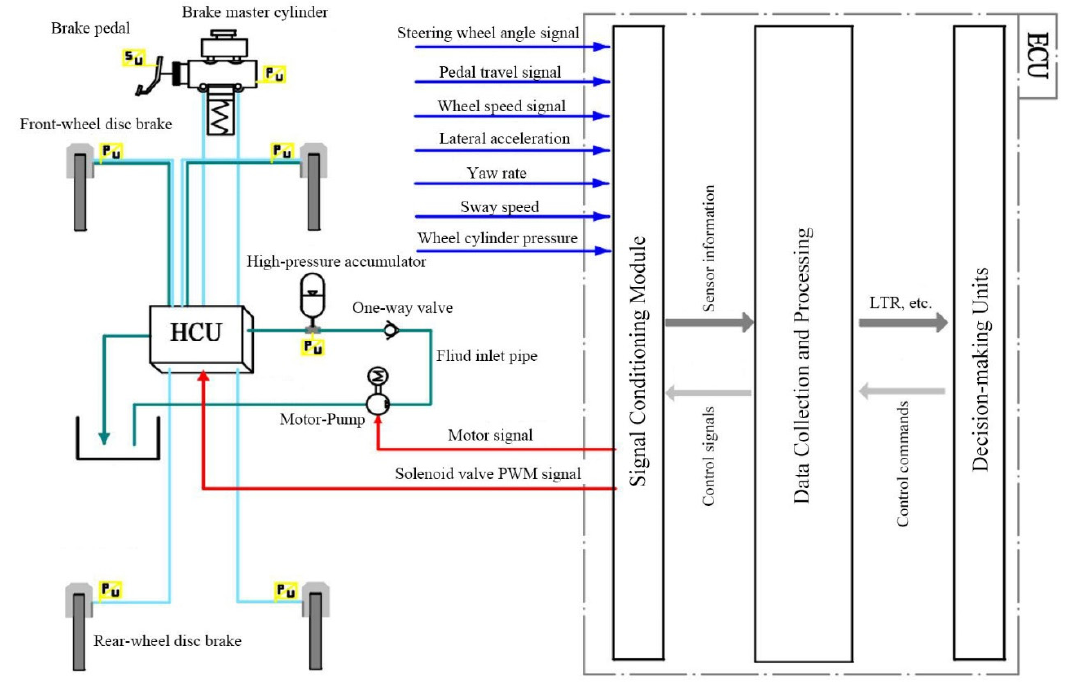
Figure 13. General drawing of the brake-by-wire system.